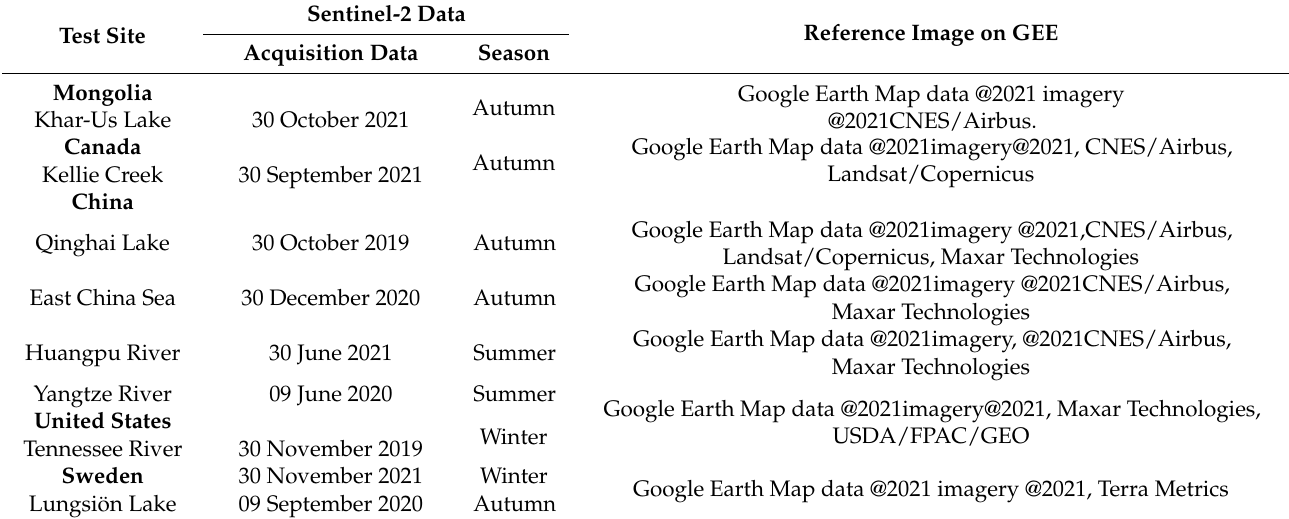
Table 3. Description of Sentinel-2 scenes and corresponding reference